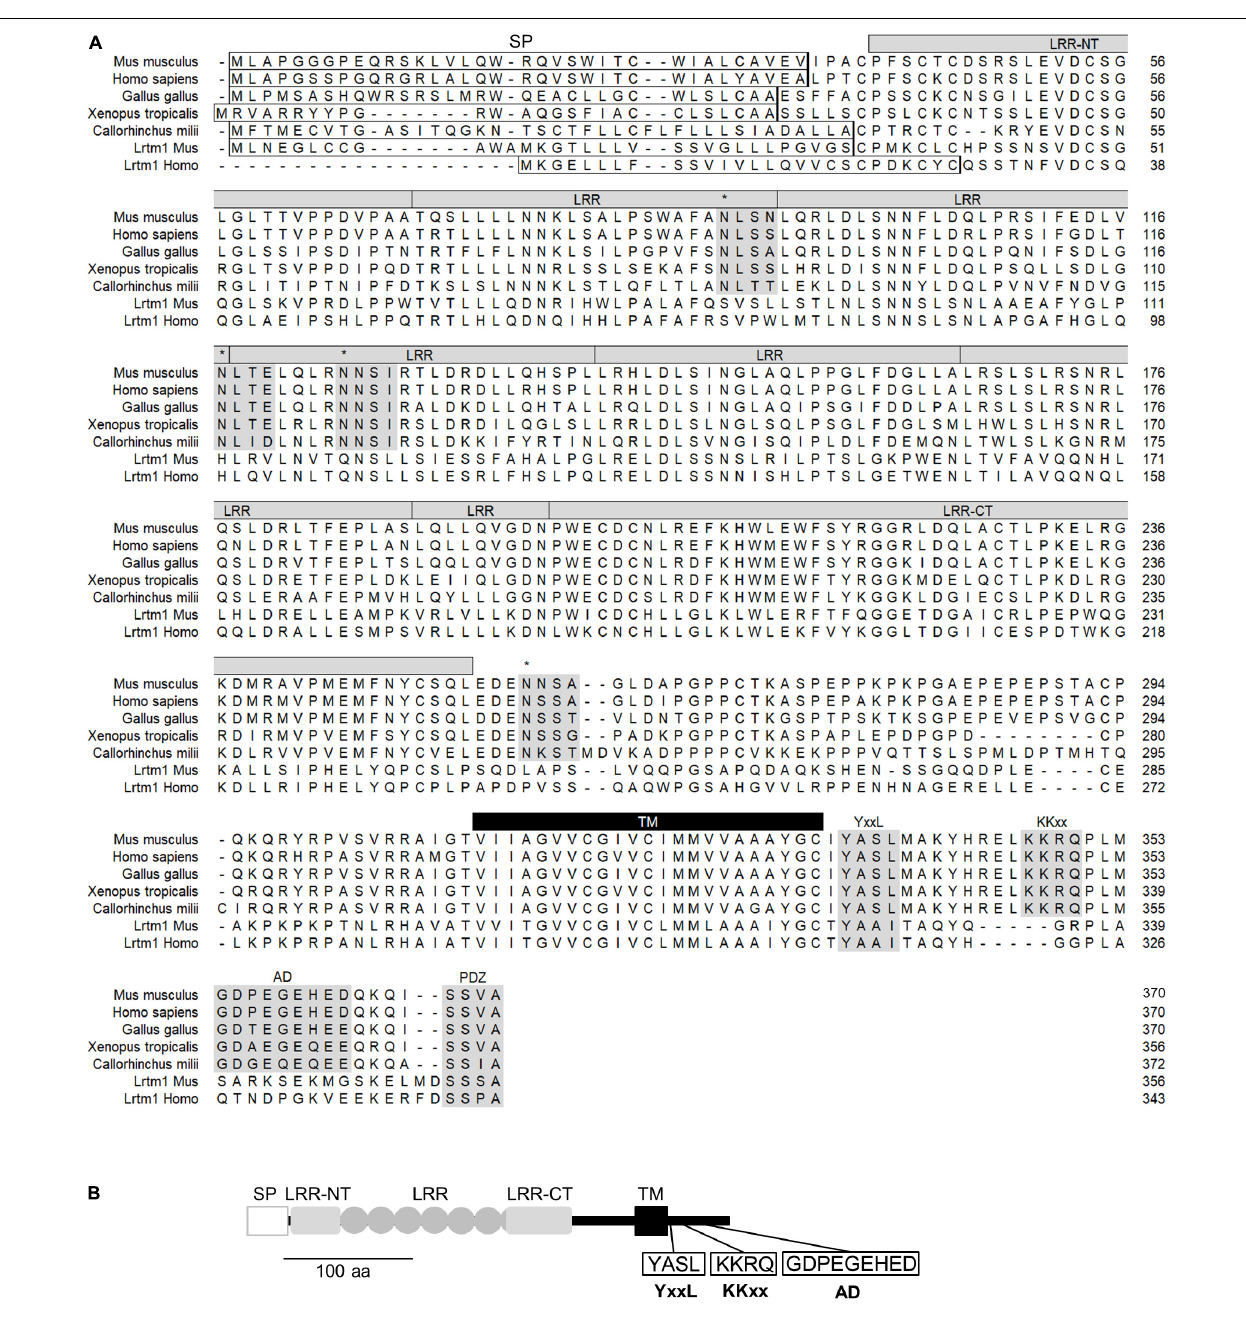
FIGURE 2 | Structure of Lrtm2 protein. (A) Sequence alignment and conserved domains of Lrtm2 proteins. N-terminal box , predicted signal peptide sequence; shaded , conserved sequence motifs. asterisks , N-glycosylation sites; LRR, Leucine-rich repeat; LRR-NT, LRR-N-terminal; LRR-CT, LRR-C-terminal; YxxL, endocytosis motif; KKxx, ER retrieving motif; AD, acidic domain known as a motif for axon targeting and KIF1-binding; PDZ, PDZ domain-binding; TM, transmembrane domain. (B) Domain structure of Lrtm2 protein. SP, signal peptide; LRR-NT and LRR-CT, cap structures of LRR domains; ellipse, a unit of Leucine-rich repeat; TM, transmembrane domain. YxxL, somatodendritic sorting signal; KKxx, ER-retrieval signal; AD, acidic residue clustered